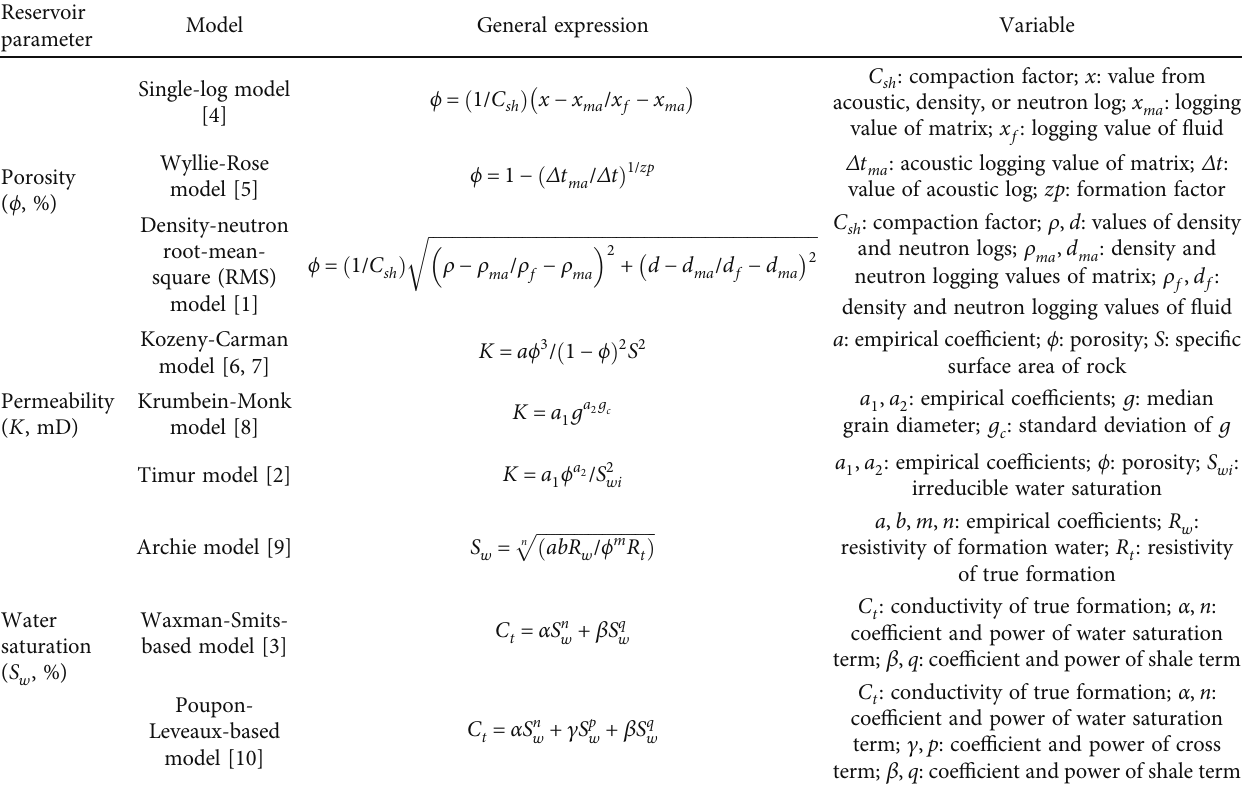
Table 1: Classic petrophysical models employed to predict e ff ective porosity, e ff ective permeability, and water saturation of conventional petroleum-bearing